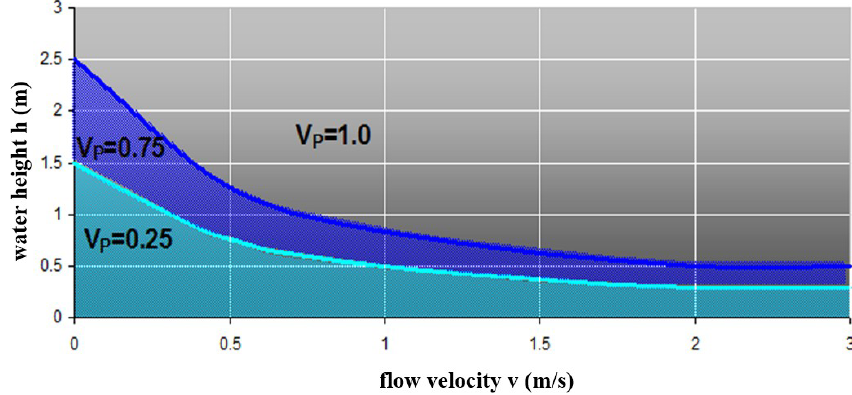
Figure 4. Physical vulnerability ( V p ) values for the population as a function of water height ( h ) and flow velocity ( v ).